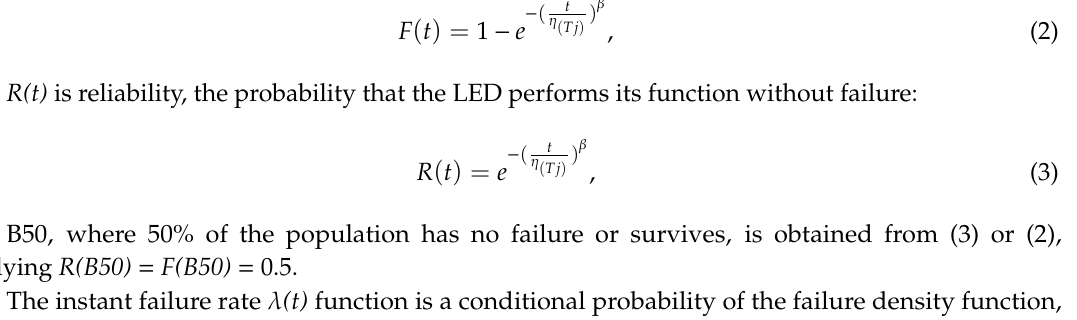
Table 3. Values of main lifetime parameters for ALT at 60 °C and evaluation results by the Arrhenius–